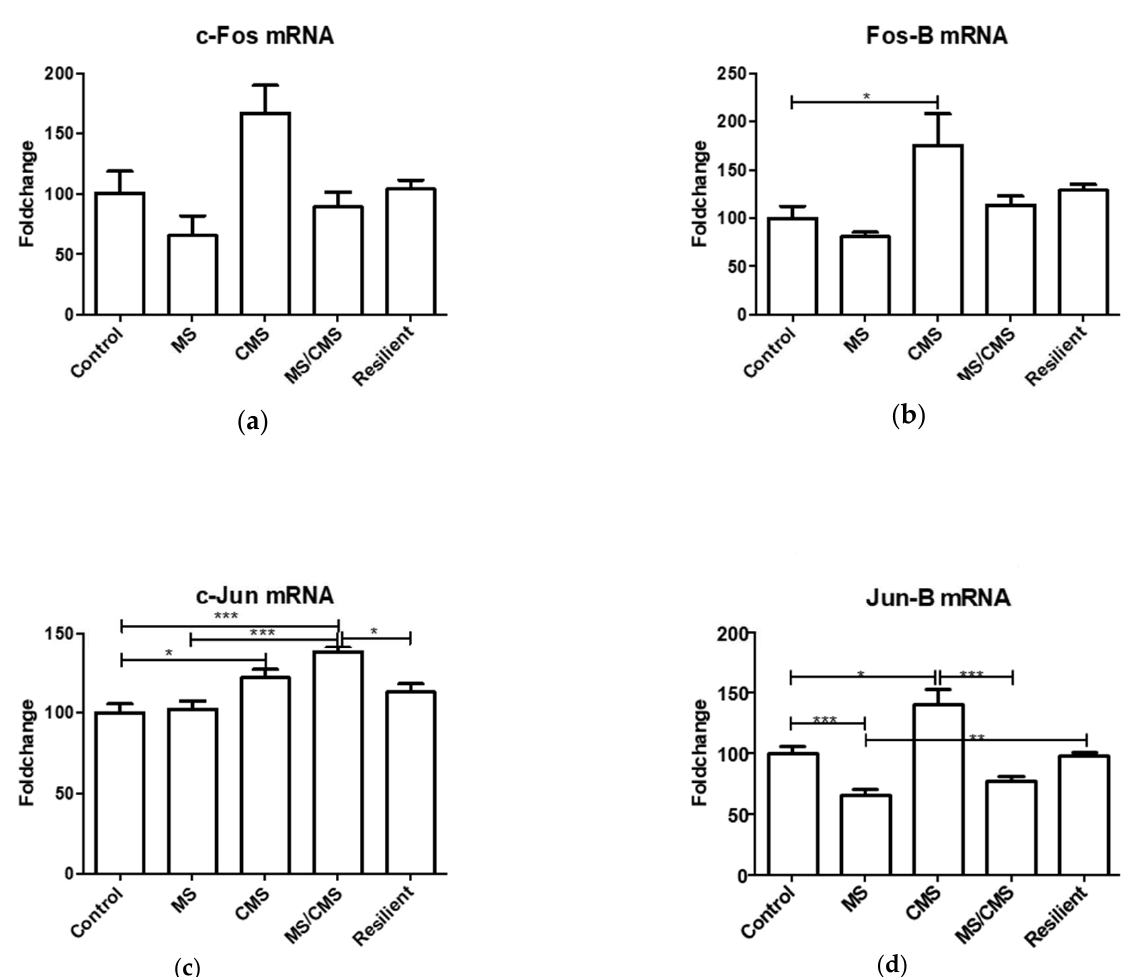
Figure 2. Expression of genes coding for the AP-1 complex: ( a ) c-Fos; ( b ) Fos-B; ( c ) c-Jun; ( d ) Jun-B Resilient: group of animals not exhibiting anhedonia after stress treatment. Data shown as mean fold change expression +/ − SEM, normalized according to the expression of ActB mRNA, * = p < 0.05, ** = p < 0.02, *** = p ≤ 0.01.